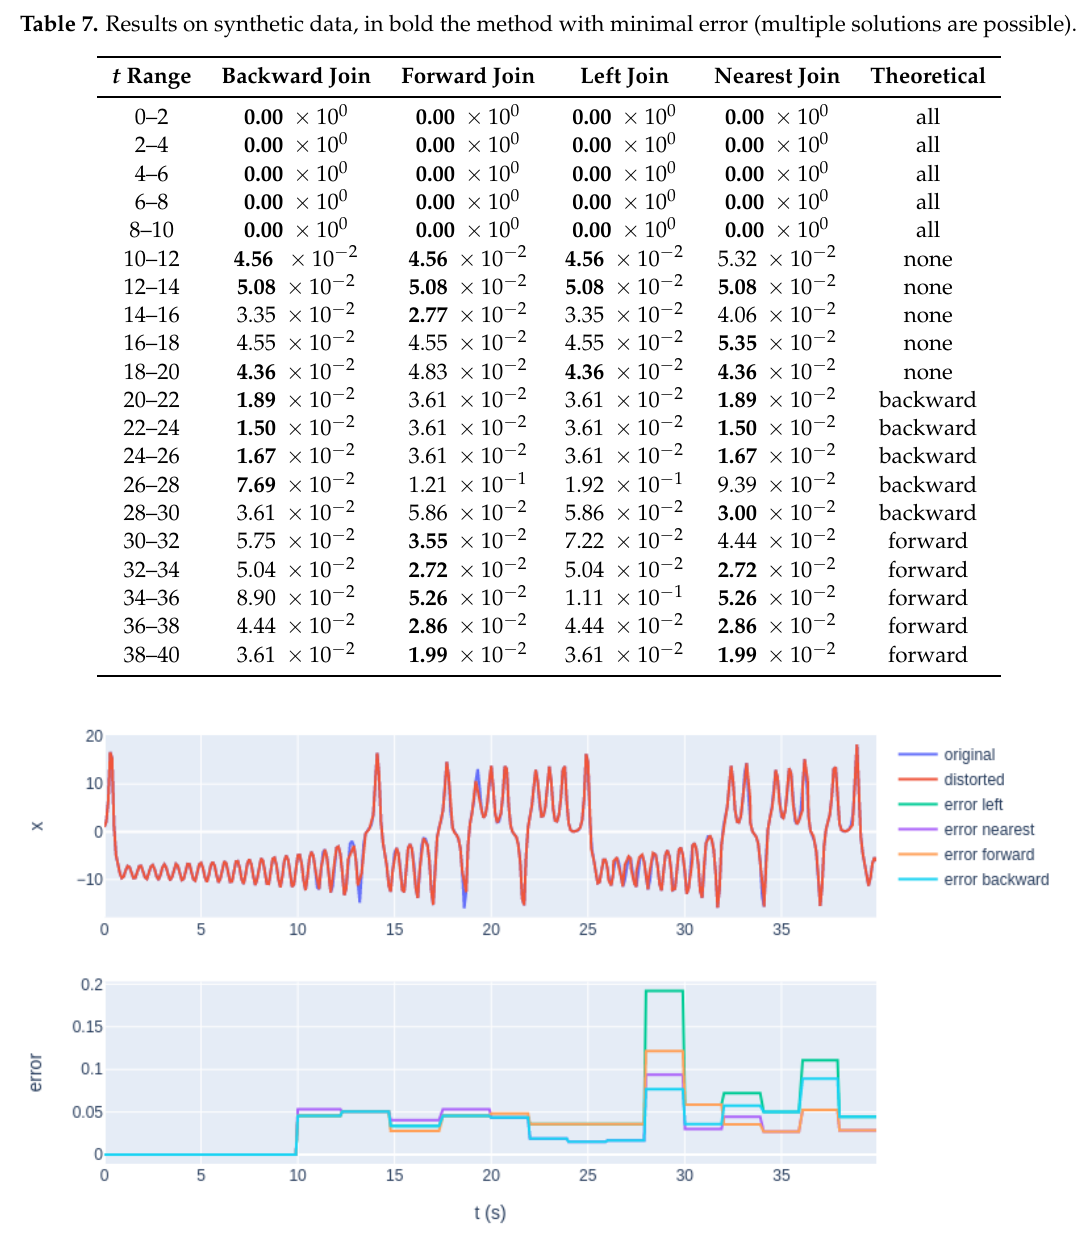
Figure 10. Synthetic data